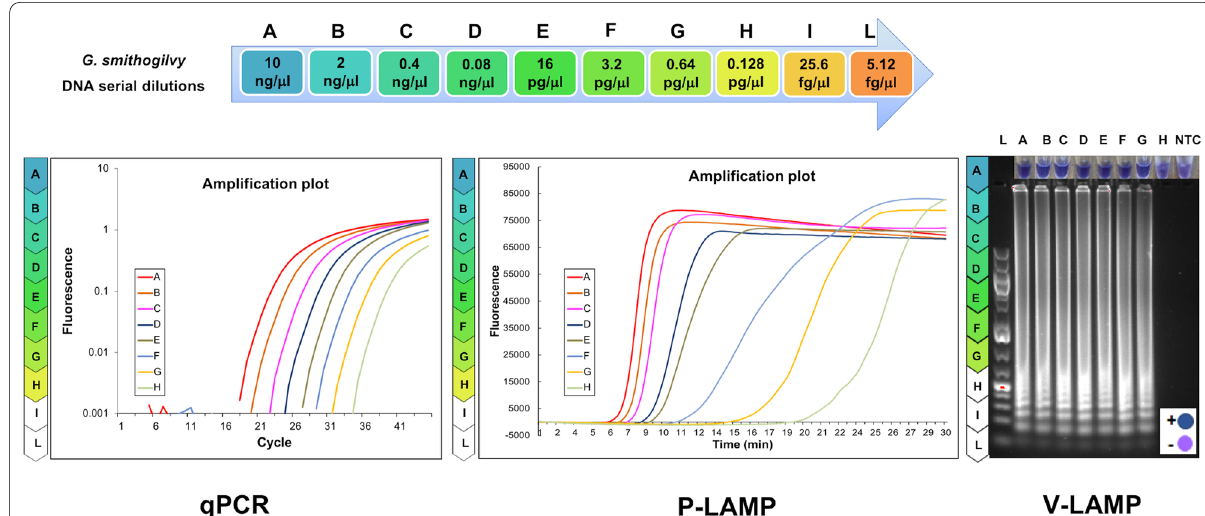
Fig. 1 Comparison of sensitivity among qPCR (left), P-LAMP (middle), V-LAMP (right) assays using ten 1:5 serial dilutions ranged between 10 ng and 5.12 fg/µL of reference Gnomoniopsis smithogilvyi DNA (strain CBS 142044). The assessment for the V-LAMP assay was based on the HNB color change visualization of the LAMP products (Positive samples blue color change in reaction, negative samples violet color reaction) and based = = on gel electrophoresis: L-1000 bp ladder, Dilutions A-G showed positive reactions while no amplification was observed in dilution H and NTC (No Template Control)